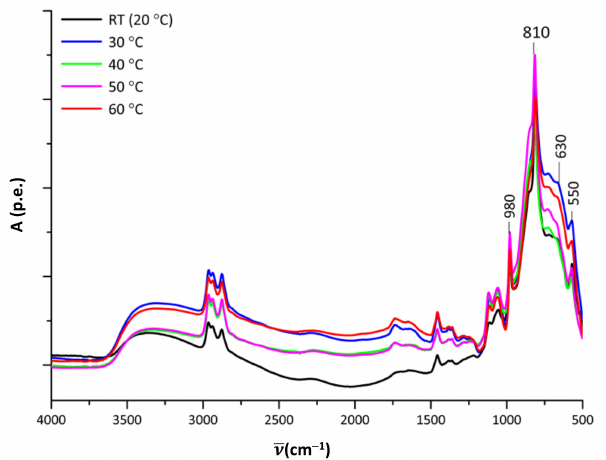
Figure 5. The IR spectra taken after the gelation of the WO 3 sol (2-propoxy ethanol) in the rheometer at the temperatures (20 ◦ C, 30 ◦ C, 40 ◦ C, 50 ◦ C and 60 ◦ C) at which the rheological properties of the sols were